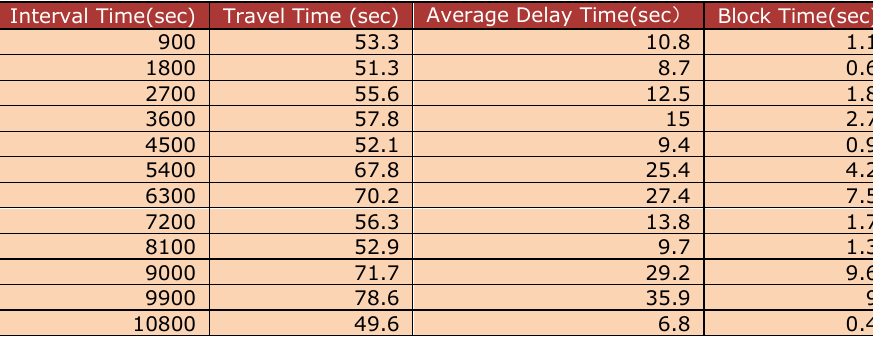
Table 5. Itinerary and Delay Time Statistics at the 1 st Congestion Position